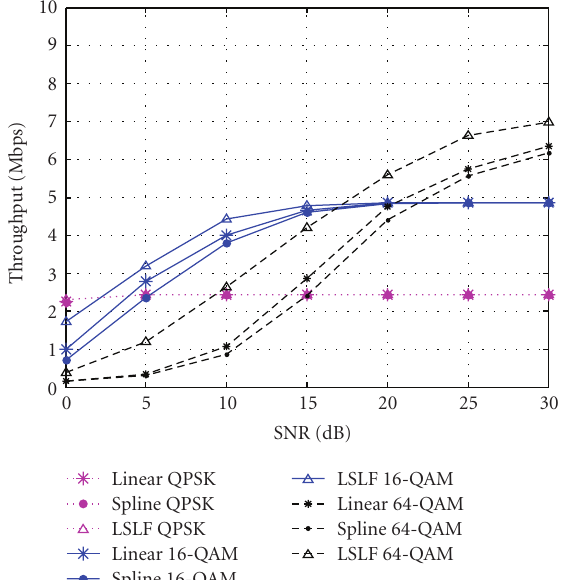
Figure 13: Throughput in Veh.A 120 km/h without using channel